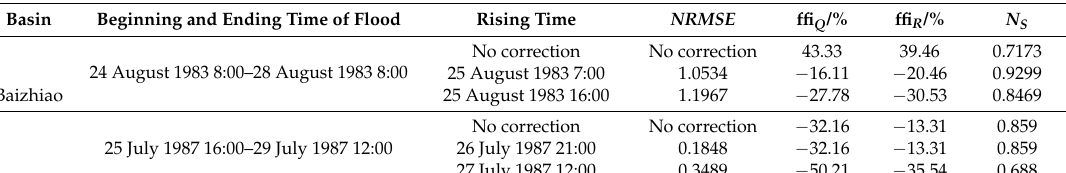
Figure 14. The flood from 24 August 1983 8:00 to 28 August 1983 8:00 in Baizhiao basin.